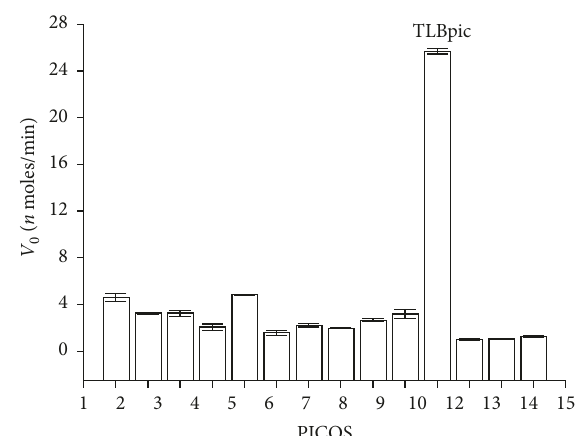
Figure 4: Determination of proteolytic activity.